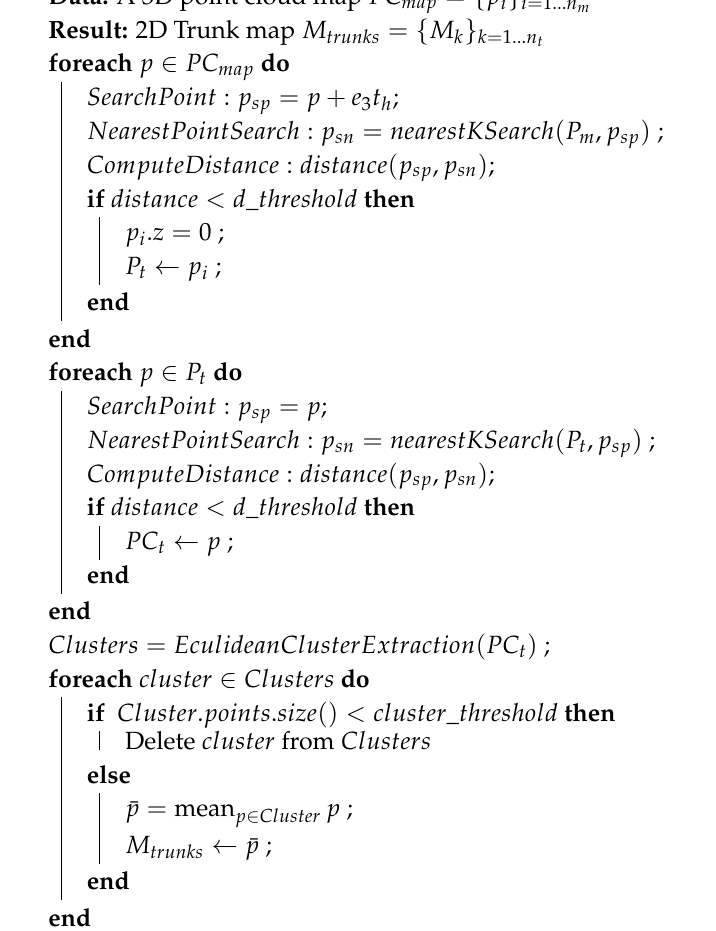
Algorithm 1: Extracting trunks from the point cloud map. Data: A 3D point cloud map PC map = { p i } i = 1... n